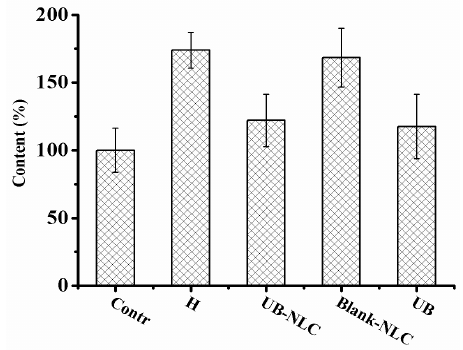
Figure 11. MDA level of HaCaT cells during culture period with or without UB-NLC.